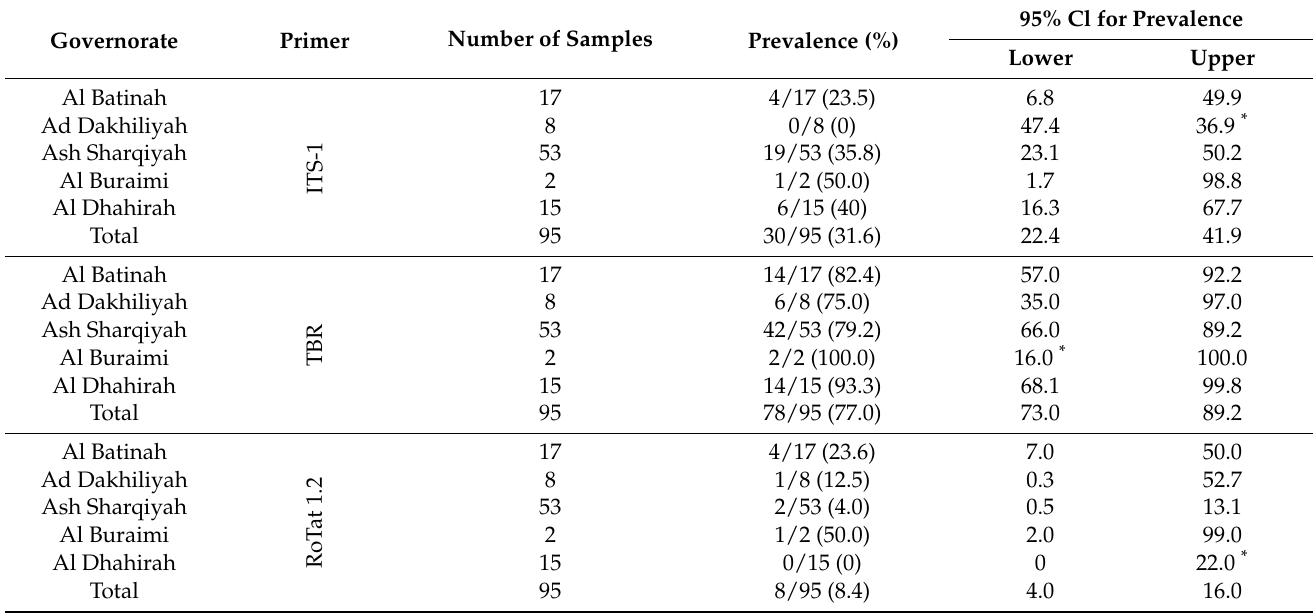
Table 1. The prevalence and the confidence interval (CI for the proportion of camels in five regions in Oman using (TBR, RoTat 1.2, ITS) PCR detection of Trypanosoma .